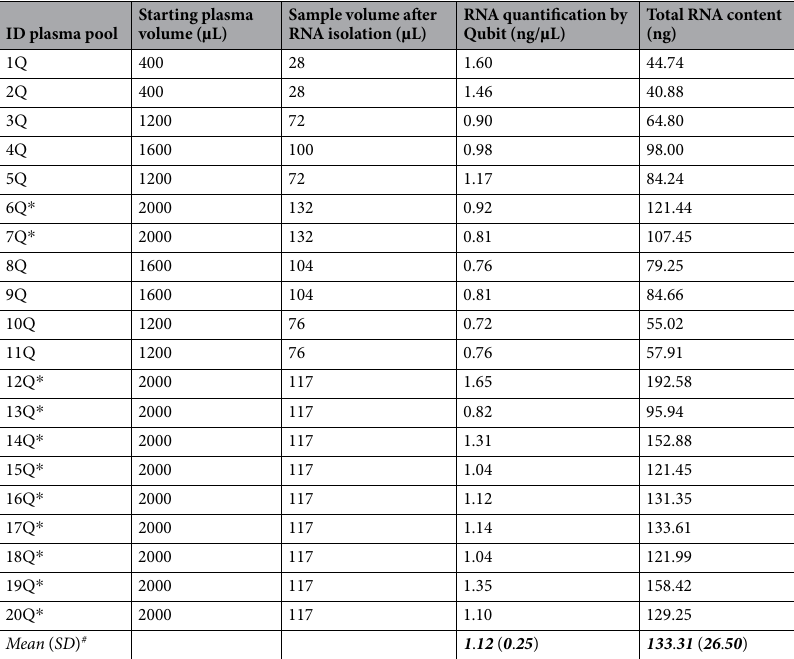
Table 4. RNA total amounts obtained from plasma samples according to the Qubit assay. # Mean and SD values of samples with starting plasma volume of 2 mL (denoted with *